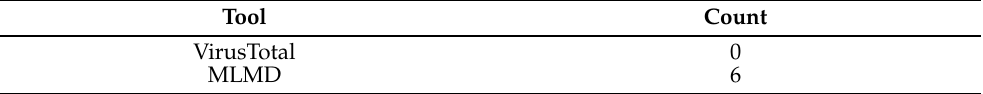
Table 20. Number of samples classified incorrectly as benign.